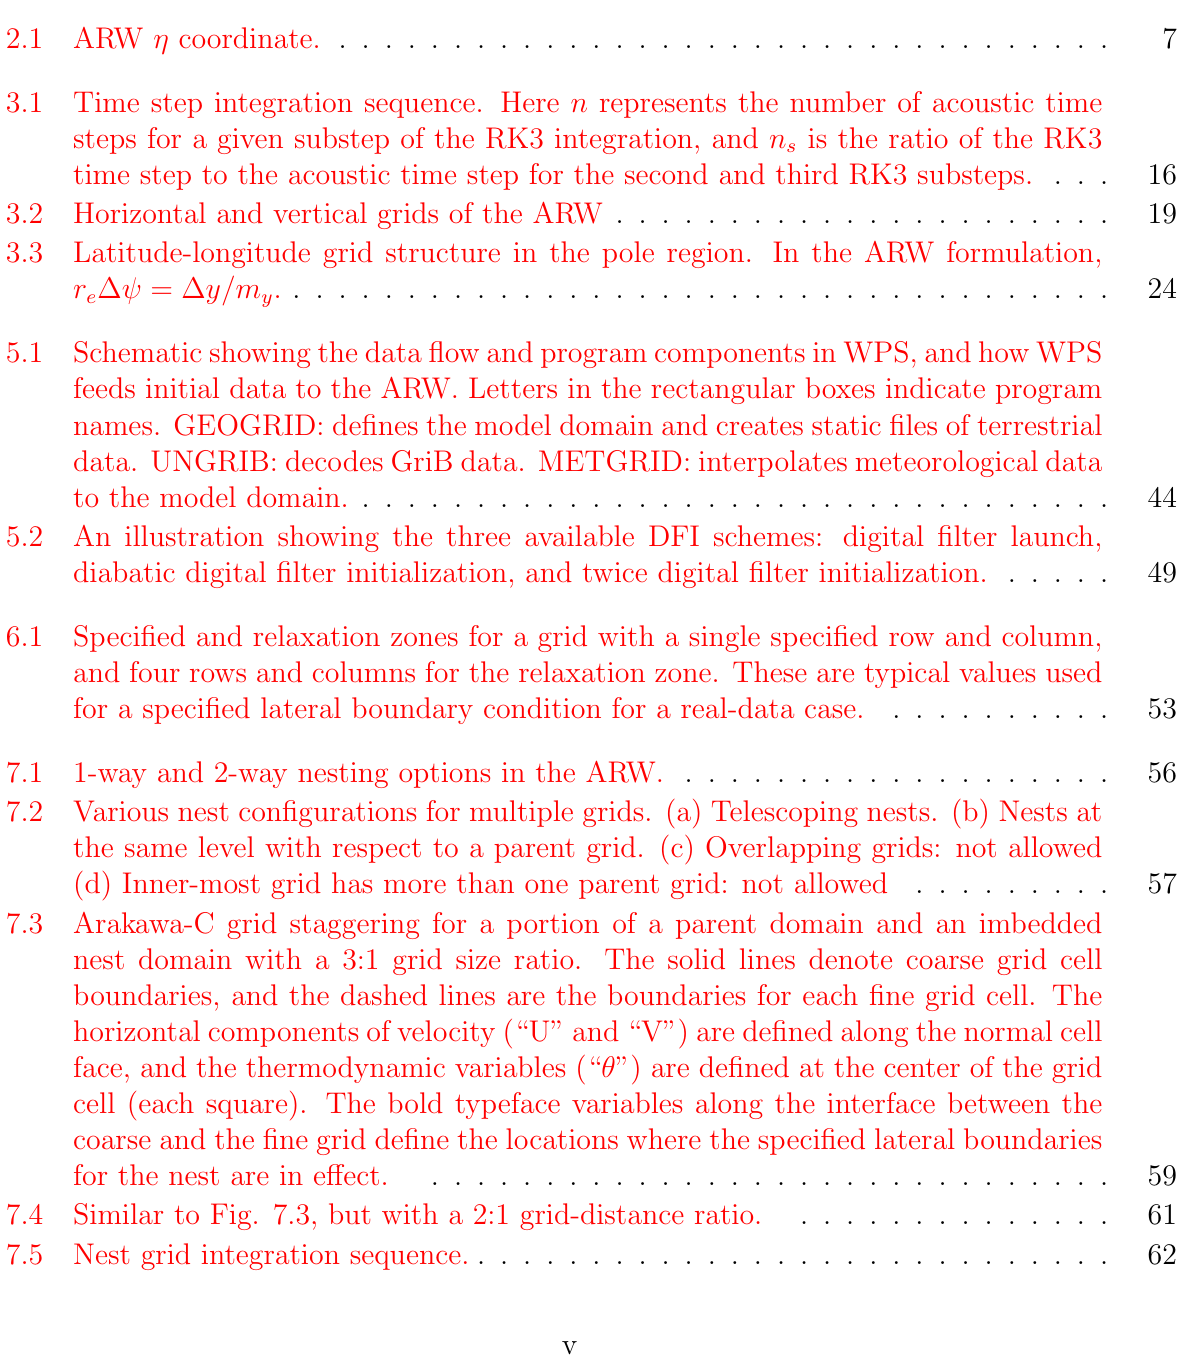
3.1 Time step integration sequence. Here n represents the number of acoustic time steps for a given substep of the RK3 integration, and n is the ratio of the RK3 s time step to the acoustic time step for the second and third RK3 substeps. . . . 3.2 3.3 Latitude-longitude grid structure in the pole region. In the ARW formulation, 5.1 Schematic showing the data flow and program components in WPS, and how WPS feeds initial data to the ARW. Letters in the rectangular boxes indicate program names. GEOGRID: defines the model domain and creates static files of terrestrial data. UNGRIB: decodes GriB data. METGRID: interpolates meteorological data 5.2 An illustration showing the three available DFI schemes: digital filter launch, diabatic digital filter initialization, and twice digital filter initialization. . . . . . 6.1 Specified and relaxation zones for a grid with a single specified row and column, and four rows and columns for the relaxation zone. These are typical values used for a specified lateral boundary condition for a real-data case. 7.2 Various nest configurations for multiple grids. (a) Telescoping nests. (b) Nests at the same level with respect to a parent grid. (c) Overlapping grids: not allowed (d) Inner-most grid has more than one parent grid: not allowed 7.3 Arakawa-C grid staggering for a portion of a parent domain and an imbedded nest domain with a 3:1 grid size ratio. The solid lines denote coarse grid cell boundaries, and the dashed lines are the boundaries for each fine grid cell. The horizontal components of velocity (“U” and “V”) are defined along the normal cell face, and the thermodynamic variables (“ θ ”) are defined at the center of the grid cell (each square). The bold typeface variables along the interface between the coarse and the fine grid define the locations where the specified lateral boundaries for the nest are in effect. 7.4 Similar to Fig. 7.3, but with a 2:1 grid-distance